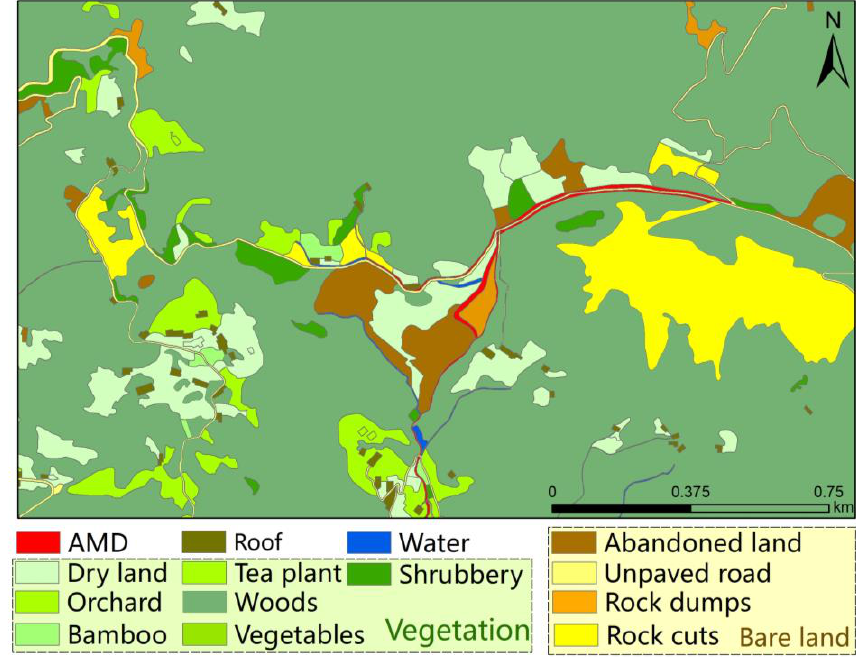
Figure 4. The latest land-use map of the stone coal mining area.